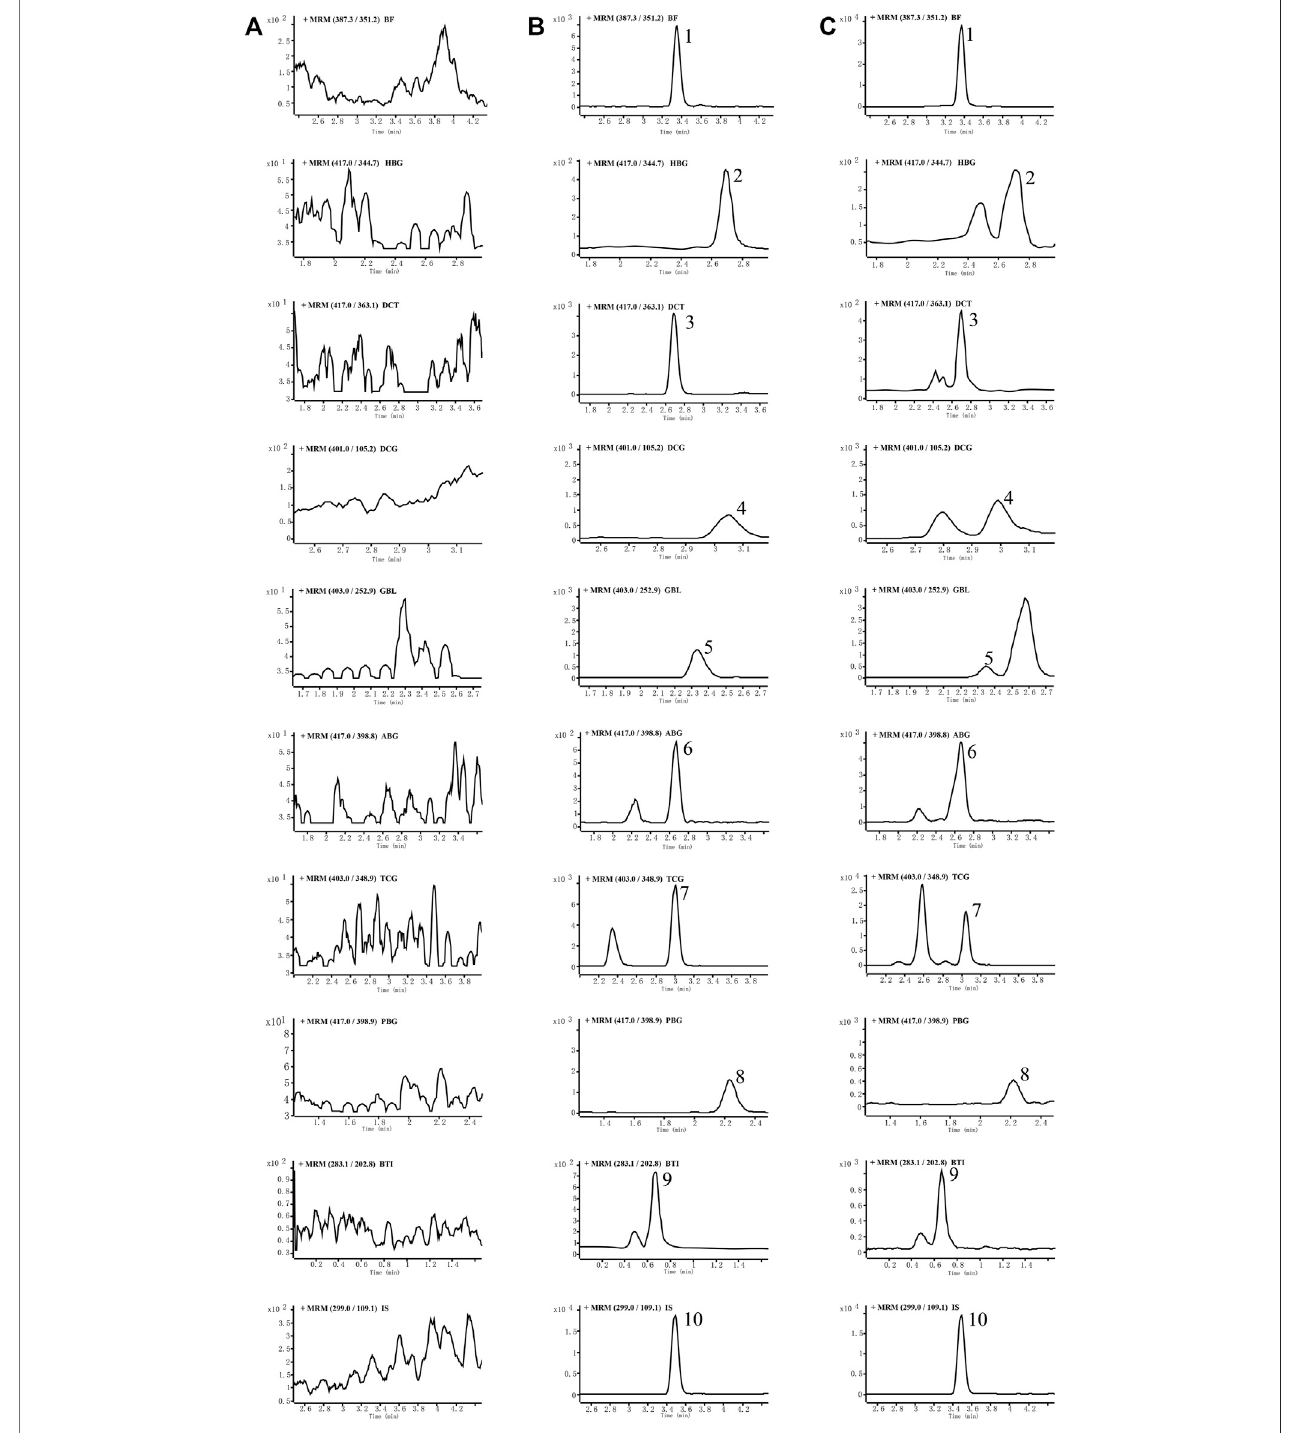
FIGURE 2| Representative MRM chromatograms ofnine analytes and internal standards (IS), in rat plasma: blank rat plasma (A) , blank rat plasma spiked with the analytesandIS (B) ,andrat plasmasamplesat 0.5 h afterdrug administration (C) .Peak1:bufalin, 2:hellebrigenin, 3:desacetylcinobufotalin,4:desacetylcinobufagin,5: gamabufotalin, 6: arenobufagin, 7: telocinobufagin, 8: pseudobufarenogin, 9: bufothionine, and 10: norethisterone (IS).